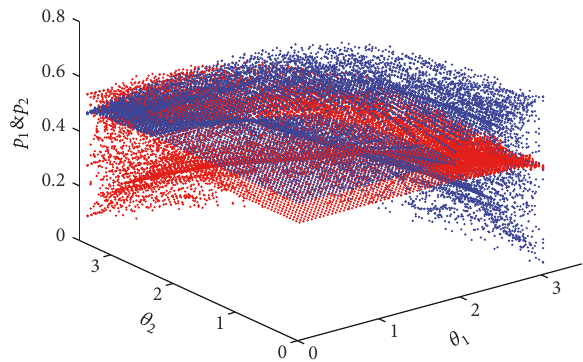
Figure 6: 3D bifurcation diagram of 𝑝 1 and 𝑝 2